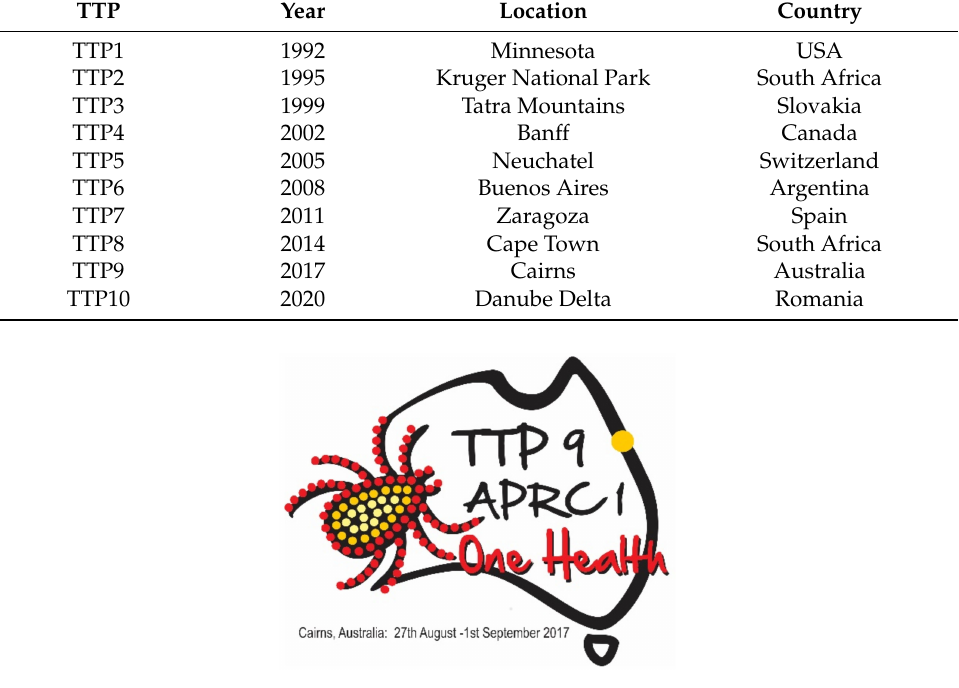
Figure 1. The TTP9APRC1 conference logo styled as the map of Australia highlighting the location of Cairns. The tick is depicted with an Australian indigenous art style with the dots representing vectored pathogens.